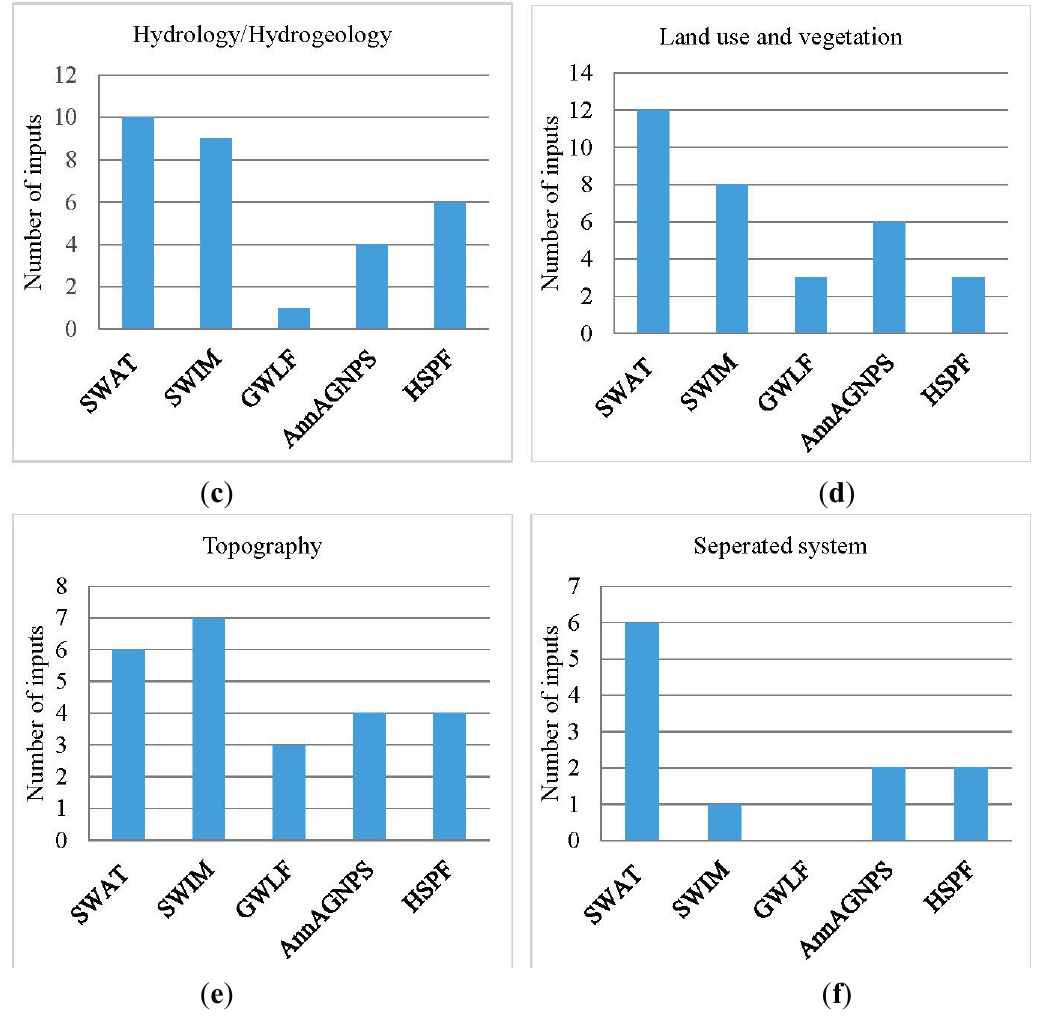
Figure 2. Amounts of inputs for each category: ( a ) climate; ( b ) soil; ( c ) hydrology/hydrogeology; ( d ) land use and vegetation; ( e ) topography; and ( f ) separated